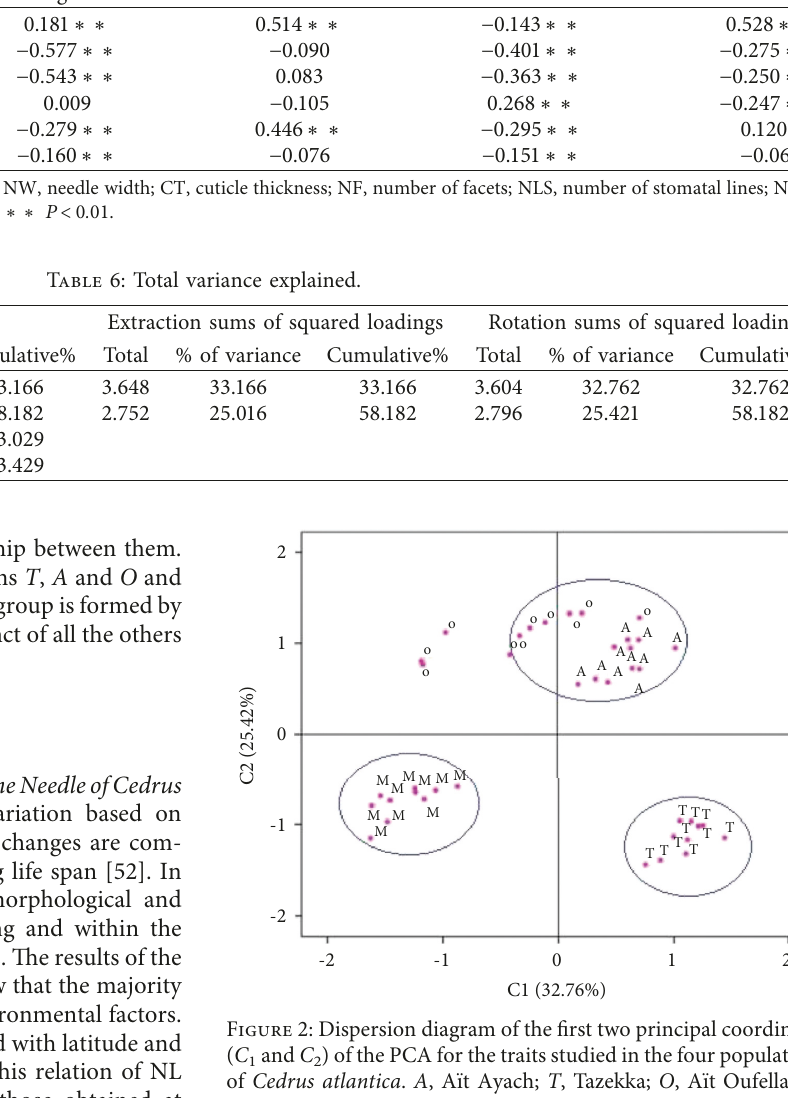
Table 5: Spearman nonparametric coefficient of correlation between single morphological traits and geographic parameters. Traits